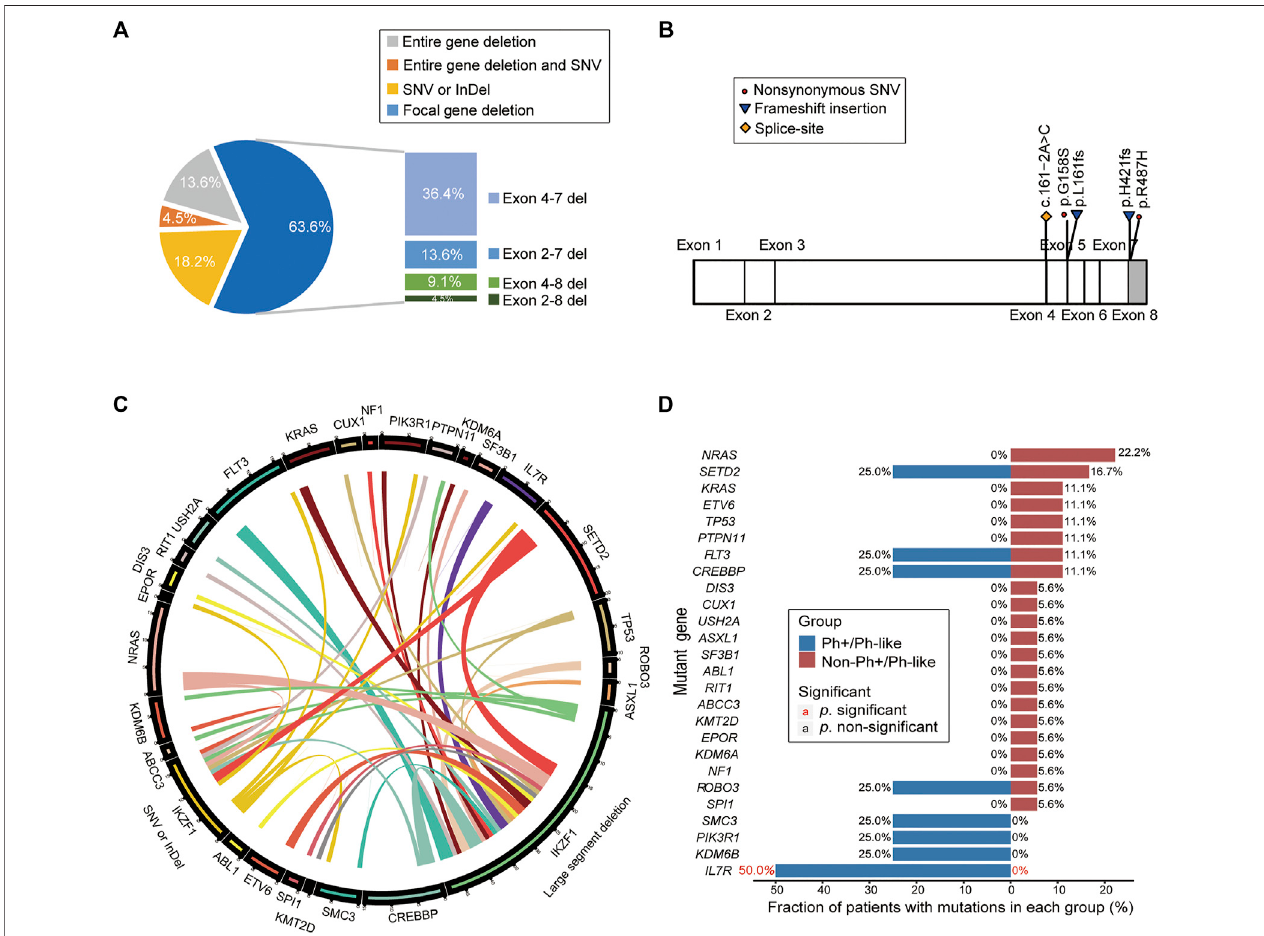
FIGURE 4 | Analysis of gene mutation characteristics in patients with IKZF1 mutation. (A) Pie chart shows speci fi c types of IKZF1 mutations, including the entire gene deletions, focal gene deletions, single nucleotide variations, and small insertions or deletions. (B) Schematic representation of the mutations detected in the IKZF1 gene, only for single nucleotide variations, and small insertions or deletions. (C) Circos plot shows all the genetic mutations in the IKZF1 mutation cohort, corresponding totherelativefrequencyandpairwiseco-occurrenceofgenemutations.Thelengthofthearcindicatesthefrequencyofmutationsinthe fi rstgene,andthewidthof the ribbon represents the percentage of patients carrying the second gene mutation. (D) Comparison of the mutational genotypes of Ph+/Ph-like positive and Ph+/Ph- like negative B-ALL with IKZF1 mutation. Percentage frequencies in each group are depicted.